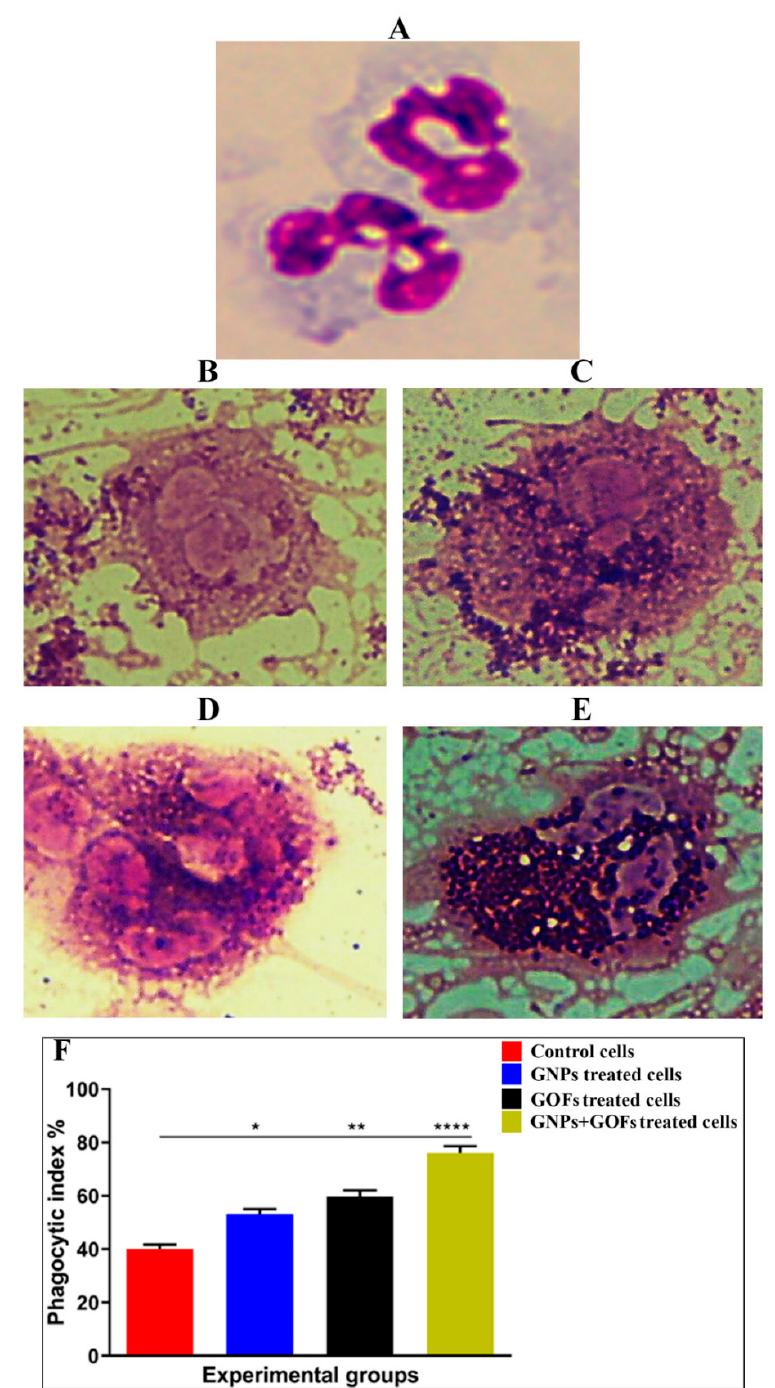
Figure 2. GNPs and GOFs increase the phagocytic index of human neutrophils. ( A ) Control unin- fected cells. ( B ) Infected cells with Staphylococcus aureus . ( C ) GNP-pretreated cells at a concentration of 10 µg/mL infected with Staphylococcus aureus . ( D ) GOF-pretreated cells at a concentration of 10 µg/mL infected with Staphylococcus aureus . ( E ) GNP- and GOF-pretreated cells at a concentra- tion of 10 µg/mL each infected with Staphylococcus aureus . The images were visualized at 100×. ( F ) Phagocytic index percentage. Data are represented as mean ± SE. Statistical significance by one- way ANOVA ( p < 0.0001) followed by posthoc testing using Tukey’s multi group comparison: * p = 0.01, ** p = 0.001, **** p < 0.0001 indicate statistically different from the control. The entry of the GNPs and GOFs demonstrated significantly ( p < 0.0001) increased phagocytosis activity at the cellular scale experiment compared to the control (Figure 2F).